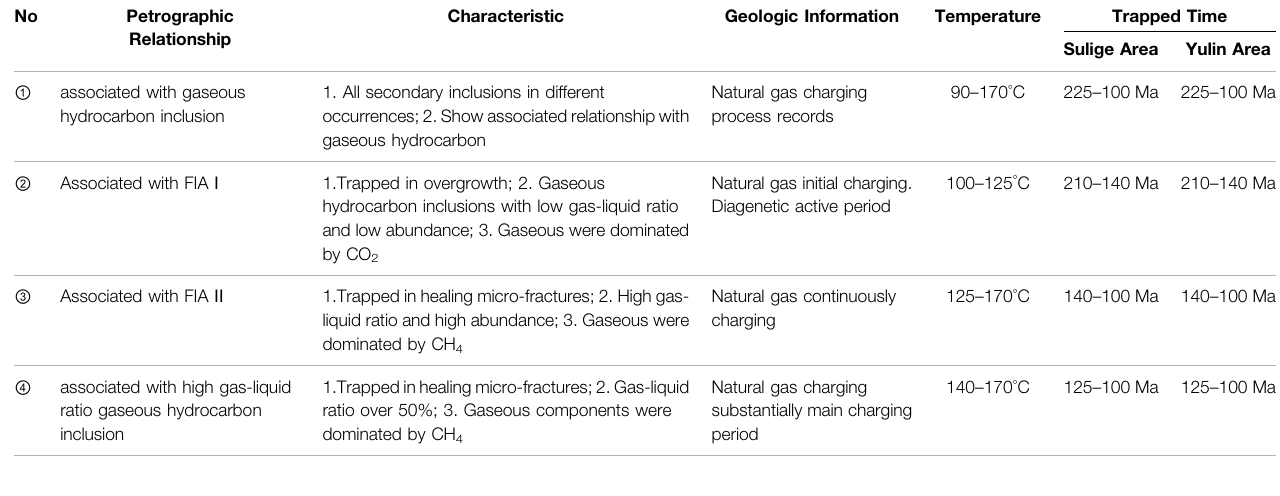
TABLE 1 | Combination features, geological signi fi cance, temperature range and estimation of trapping time of different FIAs.